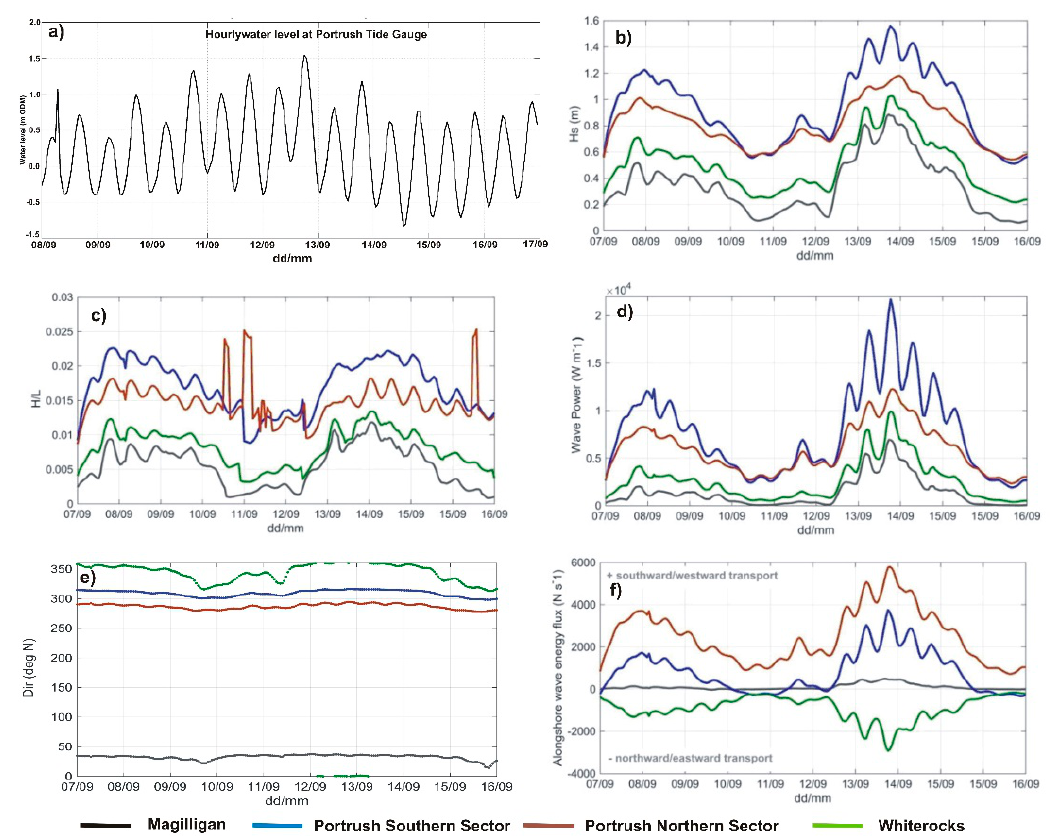
Figure 4. Water levels ( a ) at the Portrush tide gauge were reported as values above Ordnance Datum Malin (equivalent to Mean Sea Level). Wave height ( b ), wave steepness ( c ), wave power ( d ), wave direction ( e ) and alongshore wave energy flux ( f ) at different investigated sites.